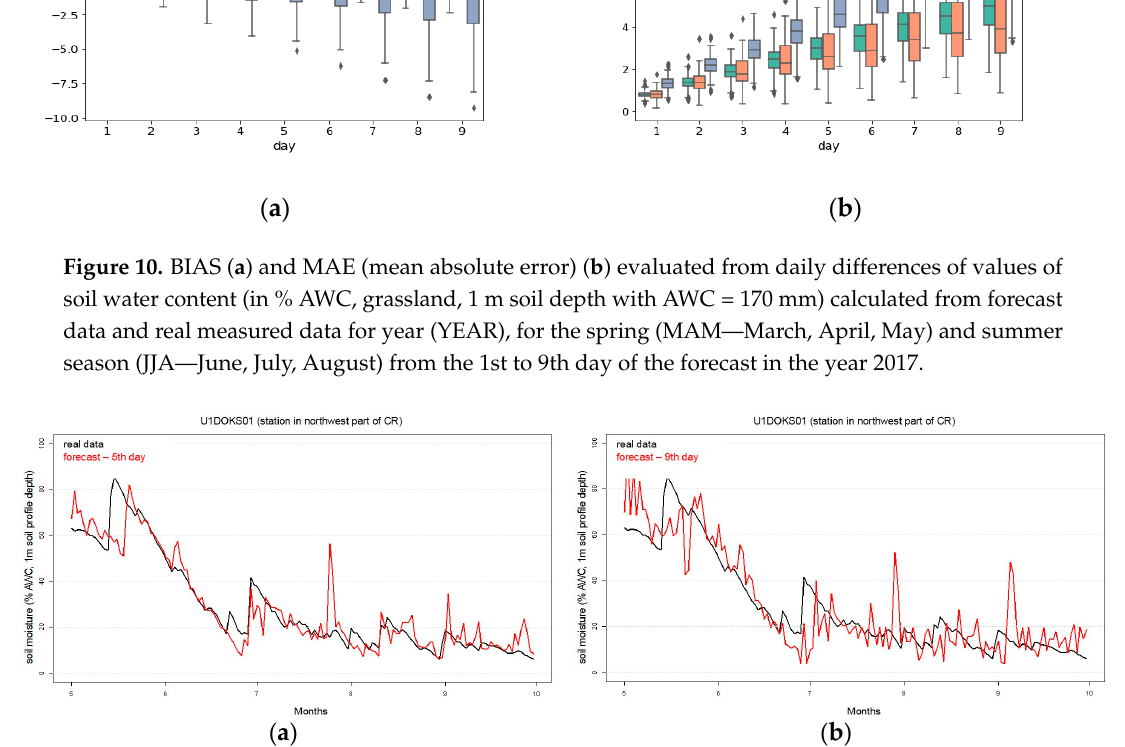
Figure 11. The course of soil moisture content (in % AWC) calculated from measured meteorological station data and forecast data for the 5th ( a ) and 9th ( b ) day of the forecast in the evaluated part of the year 2017 at Doksany station.